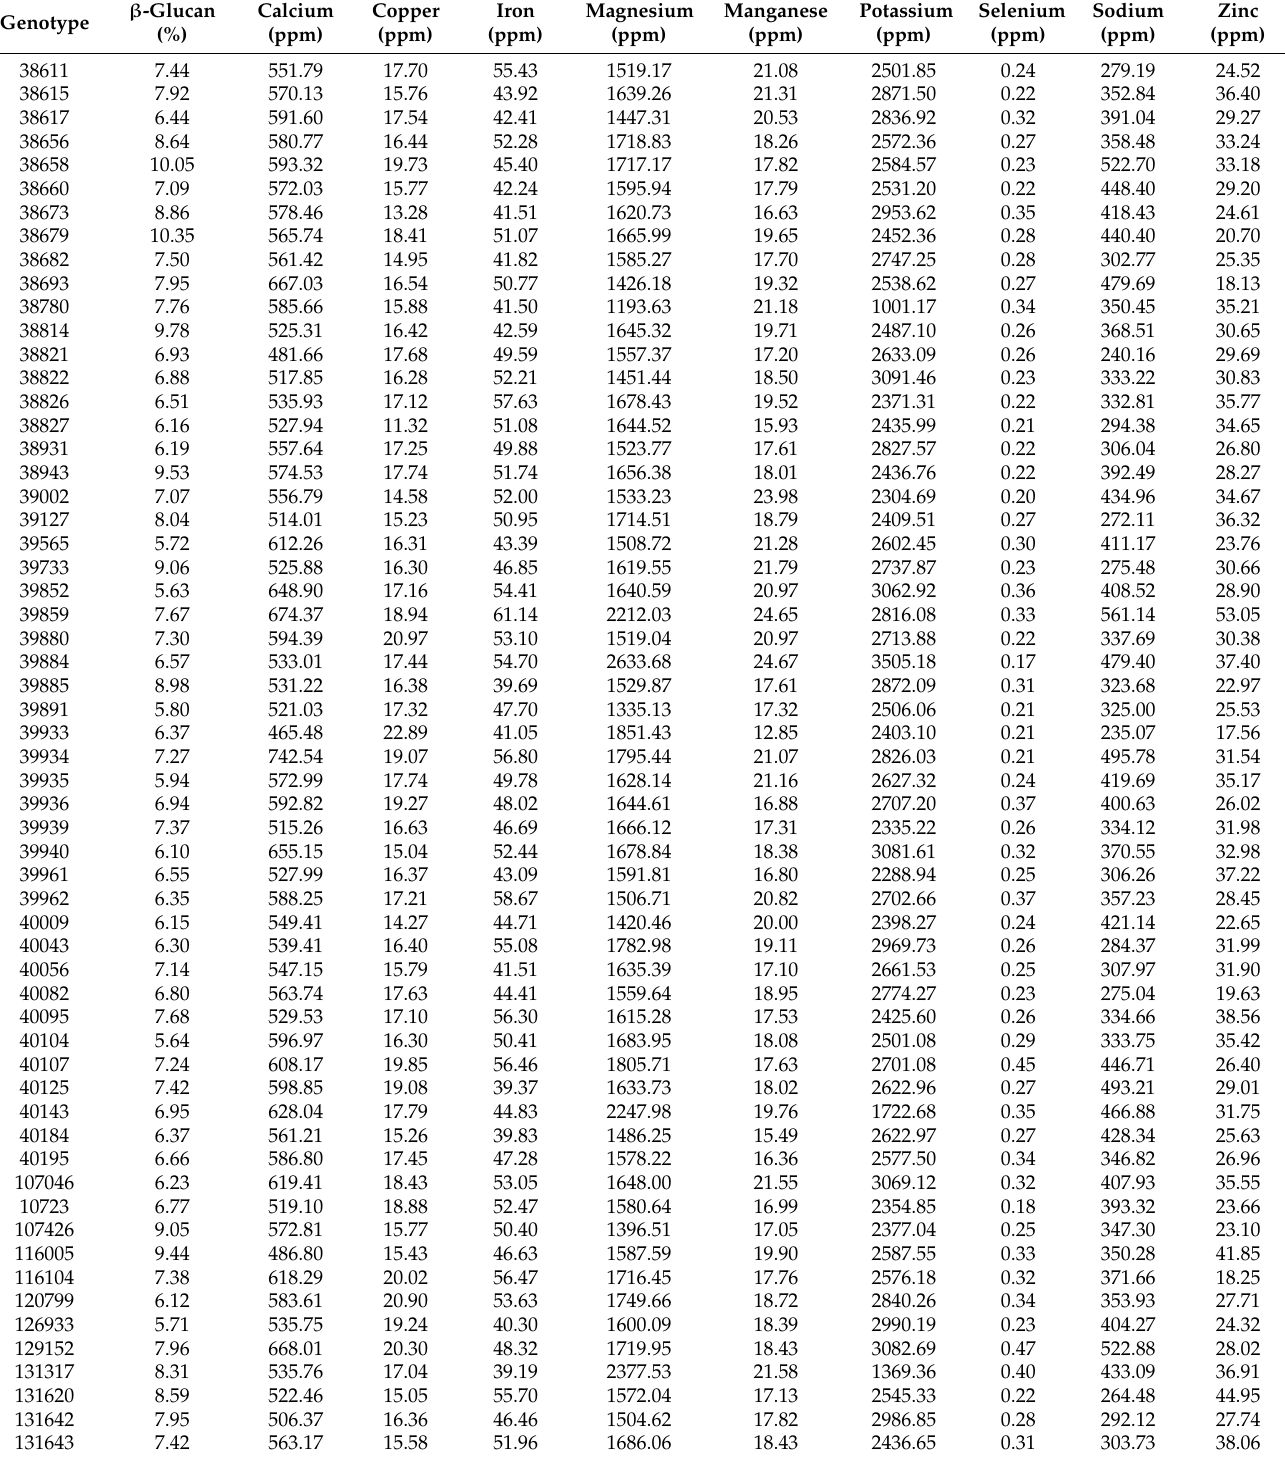
Table A1. BLUEs for Hordeum spontaneum accessions bulk seeds for β -glucan microelements